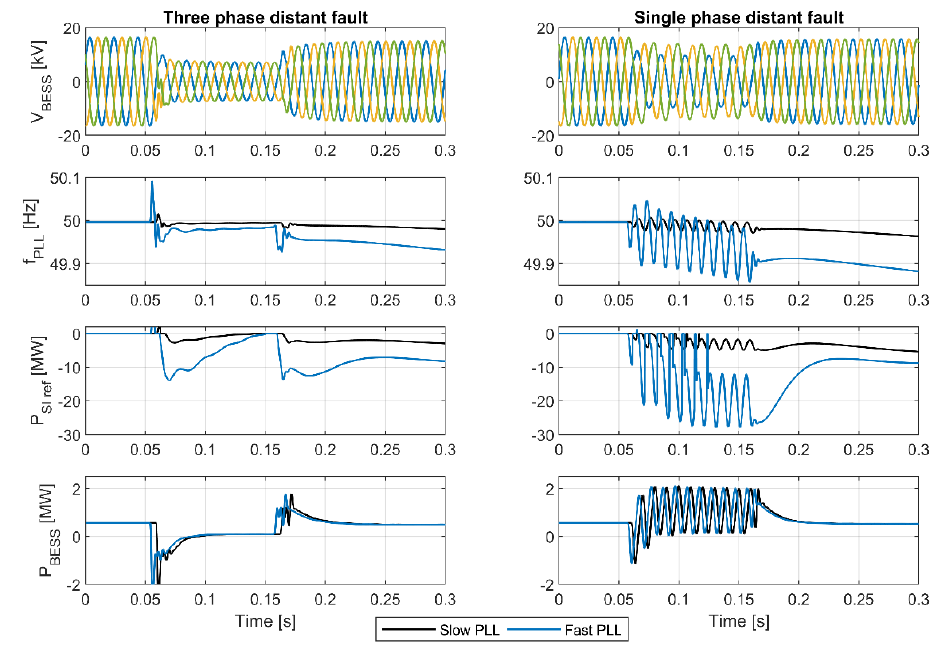
Figure 13. Comparison of SI controller response to three-phase short-circuit (left column) and singe-phase short-circuit (right column) for fast (k p = 5, T i = 0.01 s) and slow (k p = 1, T i = 0.15 s) PLL settings.